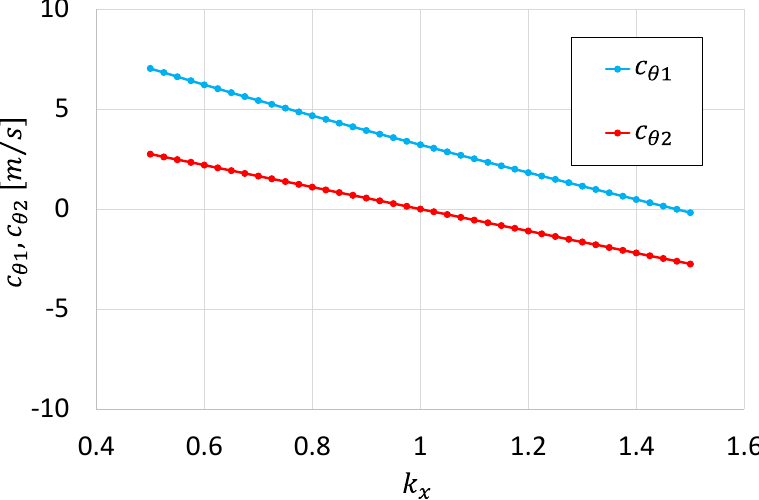
Figure 7. Tangential velocity components c θ 1 , c θ 2 . Case k u = ( 1 + k x ) /2, (combined guide vane and rotational speed regulation).